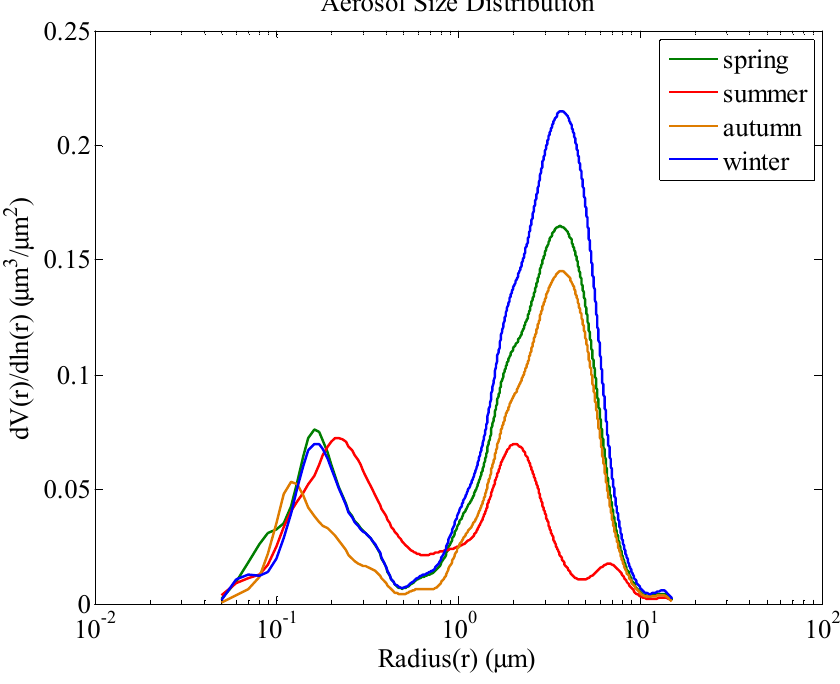
Figure 7. Seasonal variations of aerosol size distributions (ASD) in Wuhan from March 2012 to February